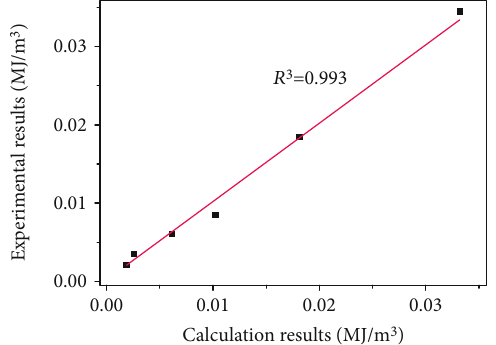
Figure 6: Correlation between calculation results and experimental results.